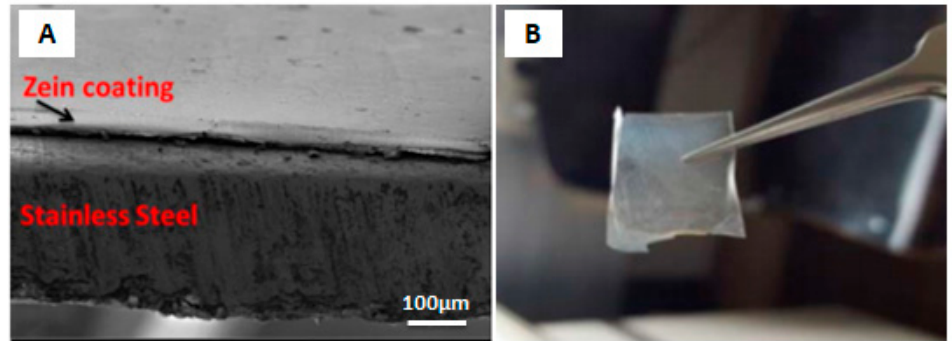
Figure 15. ( A ) SEM image of zein coating on 316L SS. ( B ) Detached zein film from substrate. Reproduced from [84] with permission from Springer™.